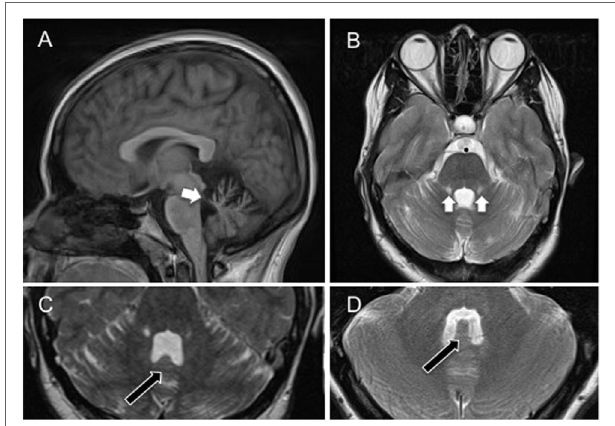
FIgURe 2 | (a) Sagittal cross-sectional T1-weighted magnetic resonance image showing atrophy of the superior cerebellar peduncles, and anterior aspects of the cerebellum (white arrow) involving the uvula and nodulus. (B) Coronal T2-weighted magnetic resonance image showing bilateral atrophy of the anterior cerebellum, including the nodulus and uvula, and superior cerebellar peduncles with associated high signal (gliotic) change. (C) Axial T2-weighted magnetic resonance image showing atrophy of the nodulus (black arrow) within the enlarged fourth ventricle. (D) Axial T2-weighted magnetic resonance image showing nodulus (black arrow) and fourth ventricle in a healthy age-matched control. Note the flattening of the nodulus and expansion of the fourth ventricle in (C)